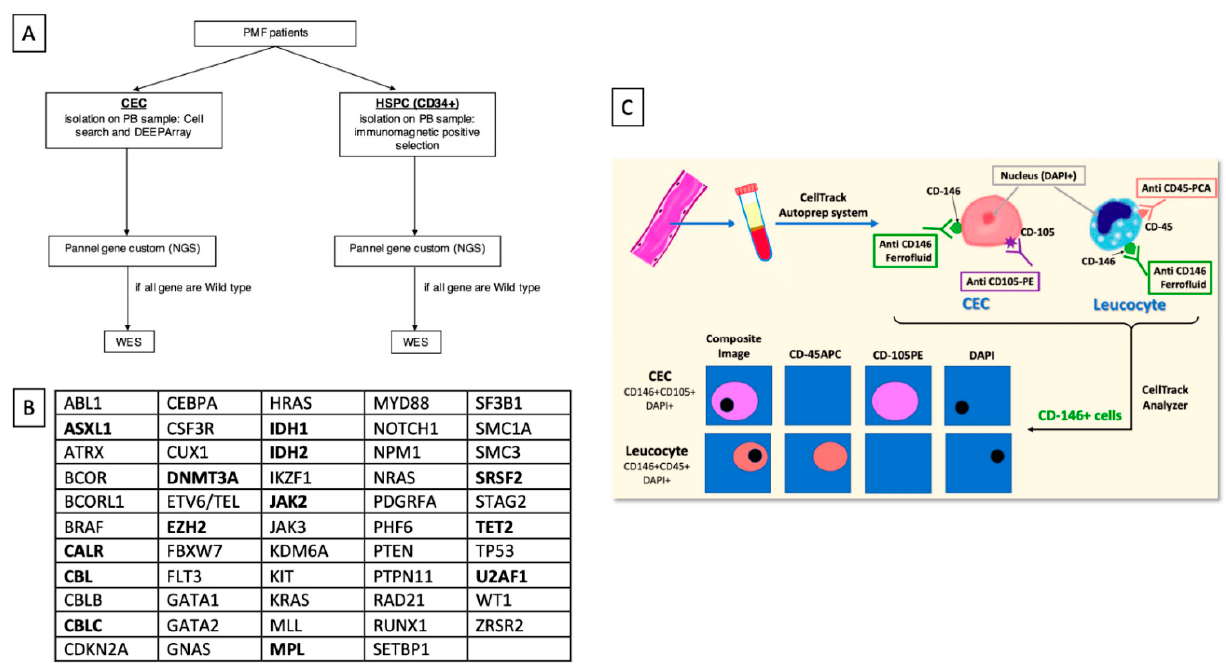
Figure 1. Study plan and CellSearch technologies. The study plan ( A ) and the 54-myeloid associated genes panel ( B ) used to investigate DNA from HSPCs and CECs. In bold the genes that are more closely related to myelofibrosis [3,4,30,31]. CECs were identify using the CellSearch system ( C ). Tubes containing 10 mL of peripheral blood are centrifuged to separate blood into plasma, buffy coat and red blood cell layer. The blood tube is then placed into the CellTrack Autoprep system where blood cells are incubated with antibodies against CD146, CD105, CD45 and are stained with DAPI. In this step, CD146-positive CECs are labeled with anti-CD105-PE antibodies while leukocytes are labeled with anti-CD45-APC antibodies. The labeled cells are then analyzed and enumerated in CellTracks Analyzer. CECs are identified as CD105-positive/DAPI-positive/CD45-negative cells while leukocytes are identified as CD45-positive/DAPI-positive/CD105-negative cells.